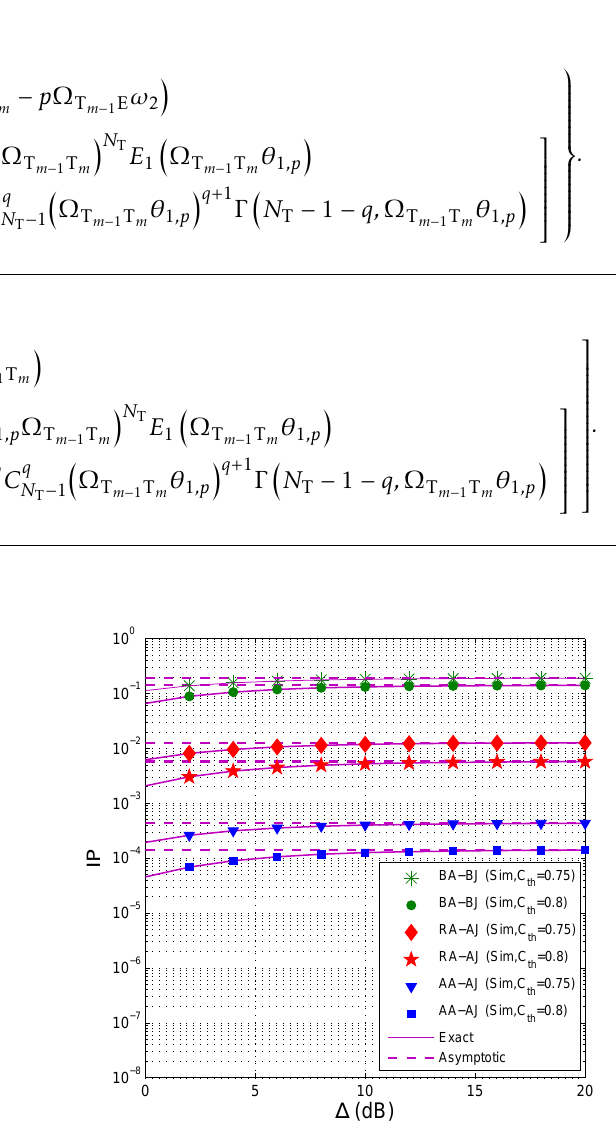
, Figure 3. IP as a function of ∆ (dB) when M = 4 , N T = 2 N E = 3 , K = 4 , α = 0 . 1 and µ 2